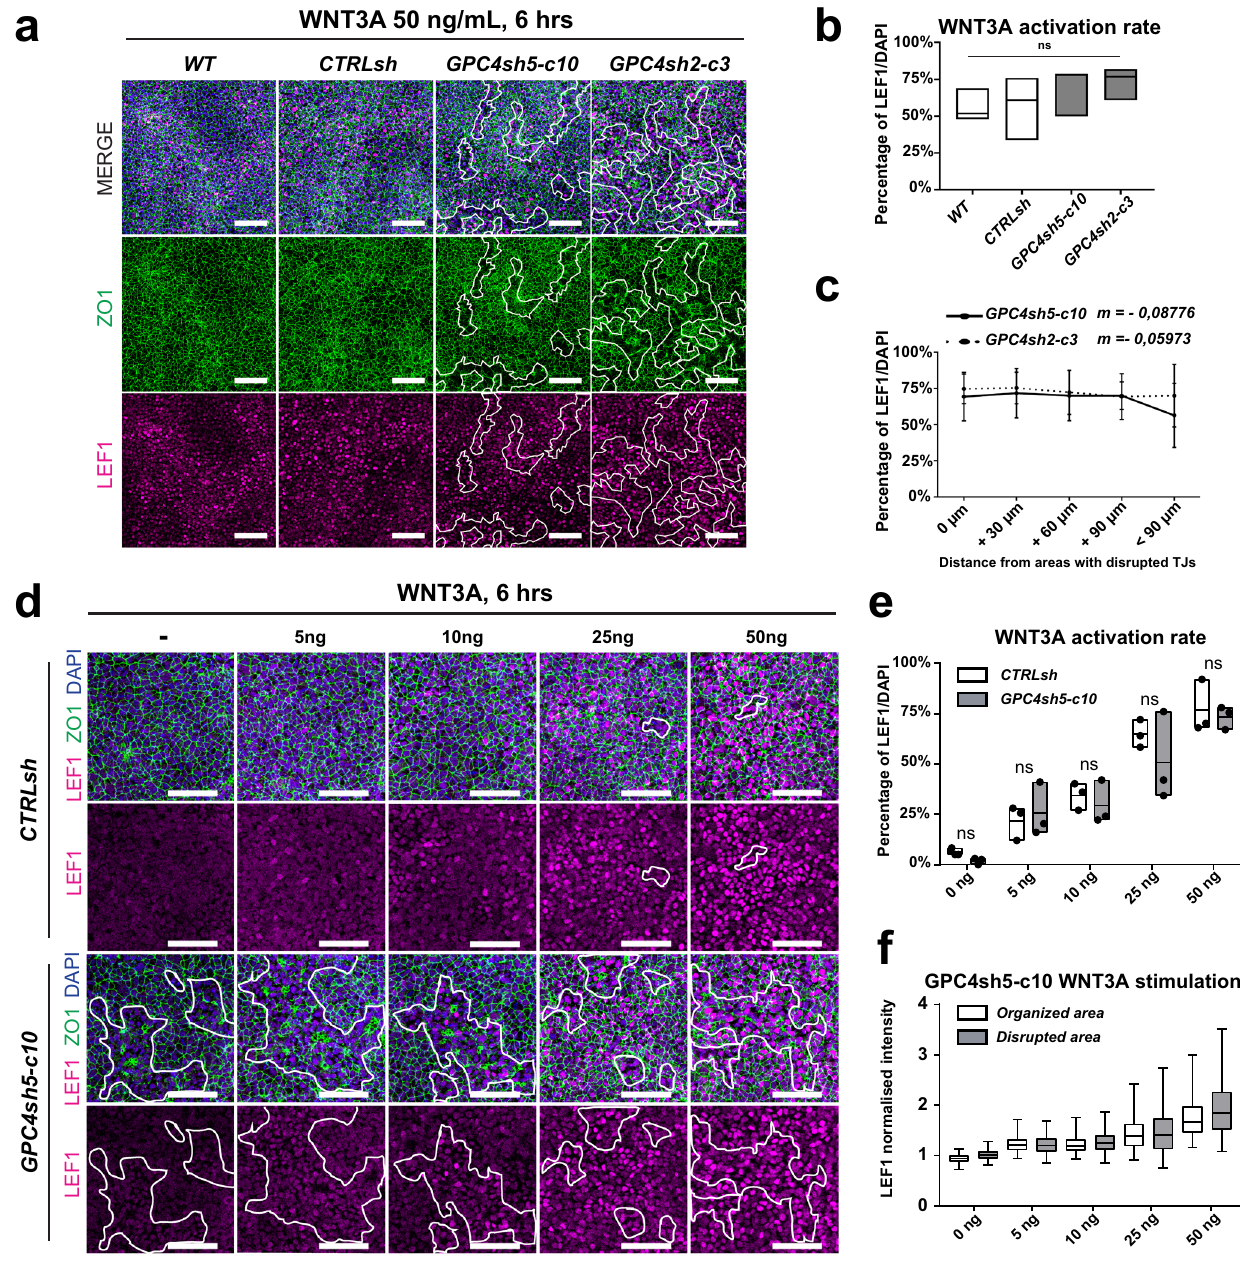
Fig. 7 | Disruption of epithelial integrity does not perturb WNT signaling activation. a Cultures of WT, CTRLsh, GPC4sh5-c10 and GPC4sh2-c3 029 hiPSCs were stimulatedfor6h with 50ng/mL of WNT3A,and analyzed forLEF1 (magenta) andZO1(green)proteins.DashedareashighlightthedisturbedTJs, n =3.Scalebar: 100 μ m . b Percentages of LEF1 expressing cells were quanti fi ed from staining in a . Box plots represent the median with min and max values, n =3. c Percentages of LEF1 expressing cells as a function of the distance from zones with disrupted TJs quanti fi ed in GPC4sh5-c10 and GPC4sh2-c3 029 hiPSCs from staining shown in a . 0 μ m indicates cells located within the zones of TJs disruption, +30 μ m, +60 μ m, +90 μ m and <+90 μ m indicate cells located at 0 – 30 µ m, 30 – 60 µ m, 60 – 90 µ m or >90 µ m from the zone of TJs disruption respectively. Data are represented as mean±SD, n =3. d Cultures of CTRLsh and GPC4sh5-c10 029 hiPSCs were stimu- lated for 6h with 5, 10, 25 and 50ng/mL of WNT3A, and then analyzed for LEF1